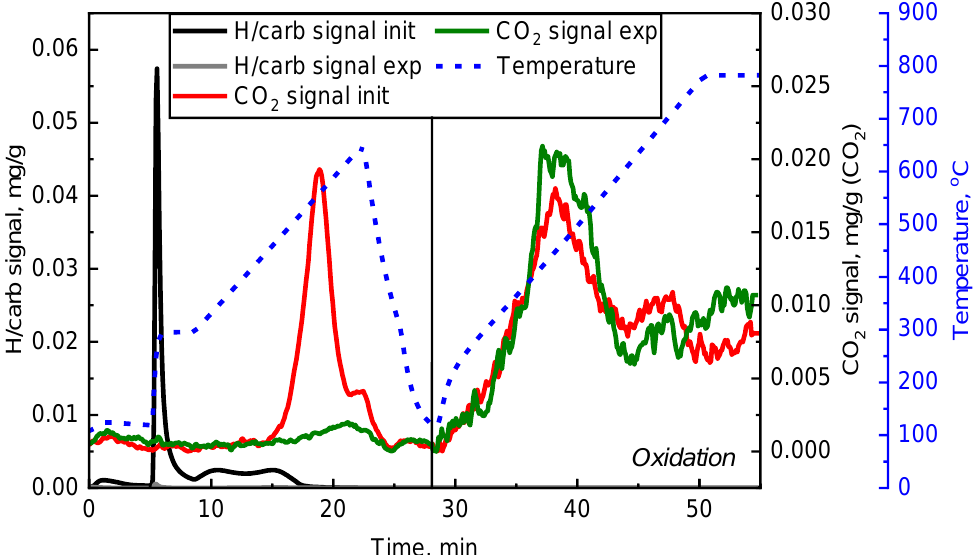
Figure 10. Pyrolytic spectra of core samples before (black and red curves) and after (grey and green curves) experiment. No. 7.